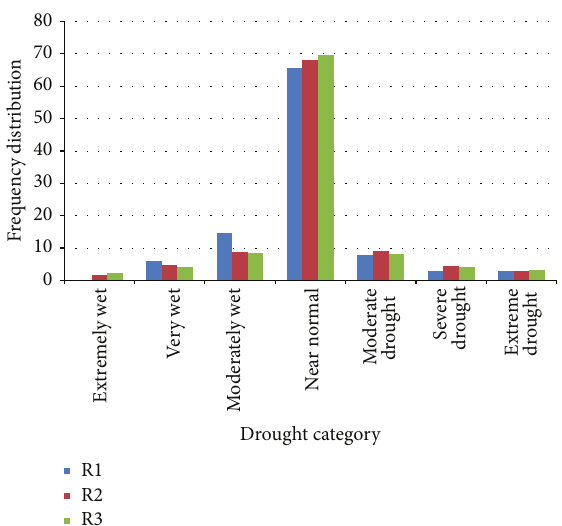
Figure 11: Frequency distribution of the RDI-12 values for each individual region during the period